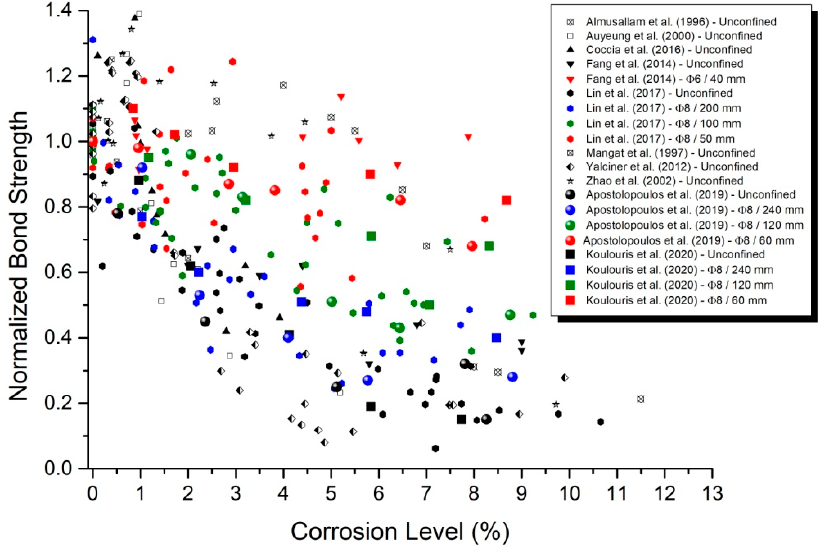
Figure 6. Normalized bond strength due to corrosion as a function of corrosion level (percentage mass loss) of the tensile reinforcing bar, data from [16,17,21,23,26,41–45].